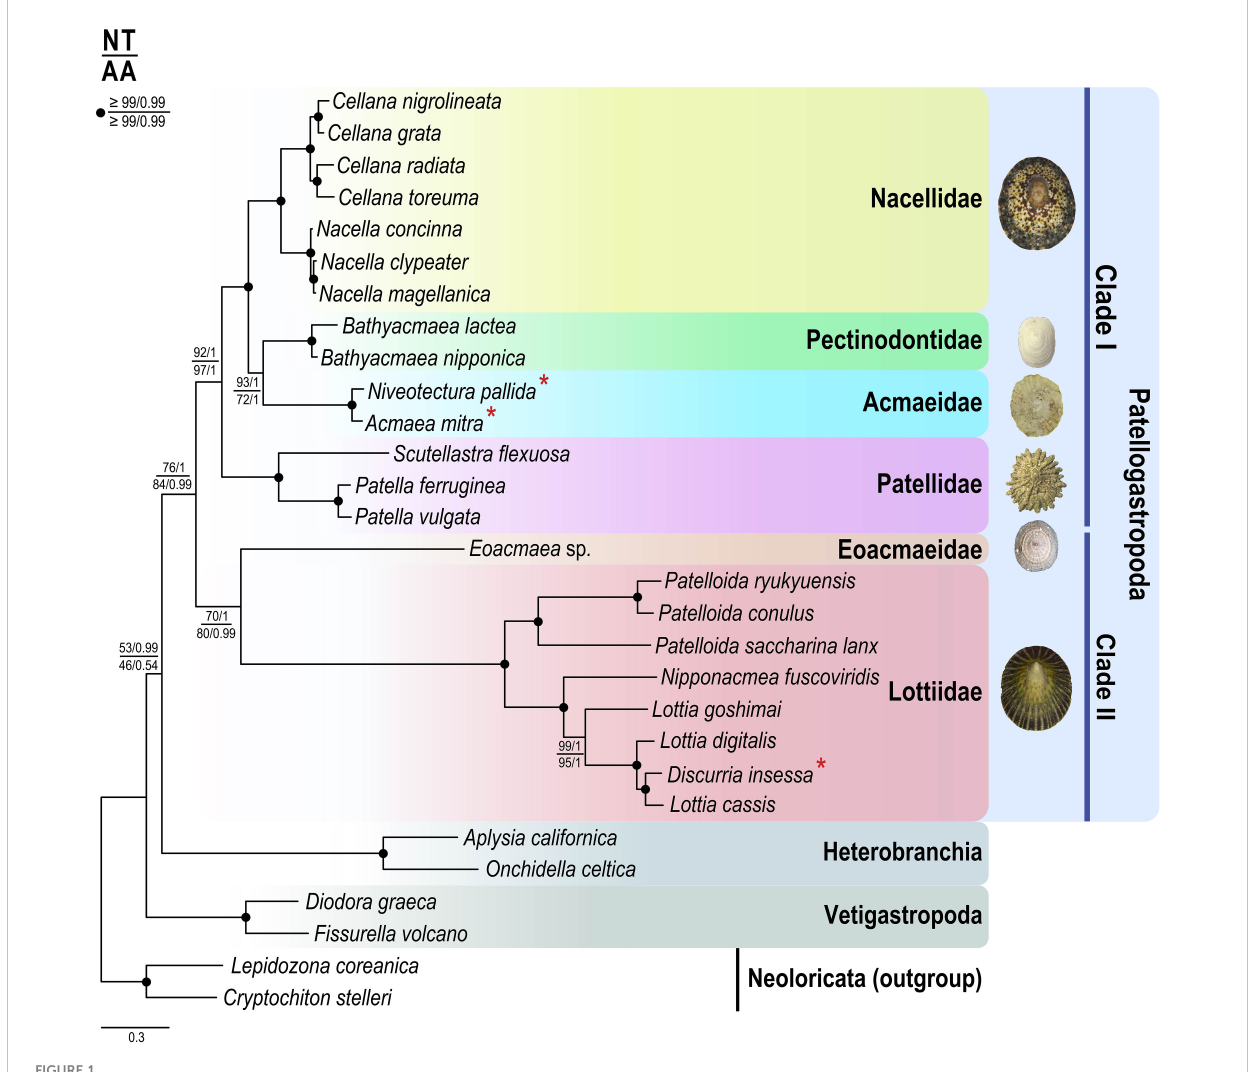
FIGURE 1 Phylogenetic relationships among Patellogastropoda species inferred from maximum likelihood and Bayesian methods for concatenated nucleotide and amino acid sequences of 13 protein-coding genes of the complete mitochondrial genomes. Node supporting values are indicated as BP (bootstrap percentage)/BP (Bayesian posterior probability) in ML and BI, respectively. An asterisk (*) denotes mtDNA sequences newly determined in this